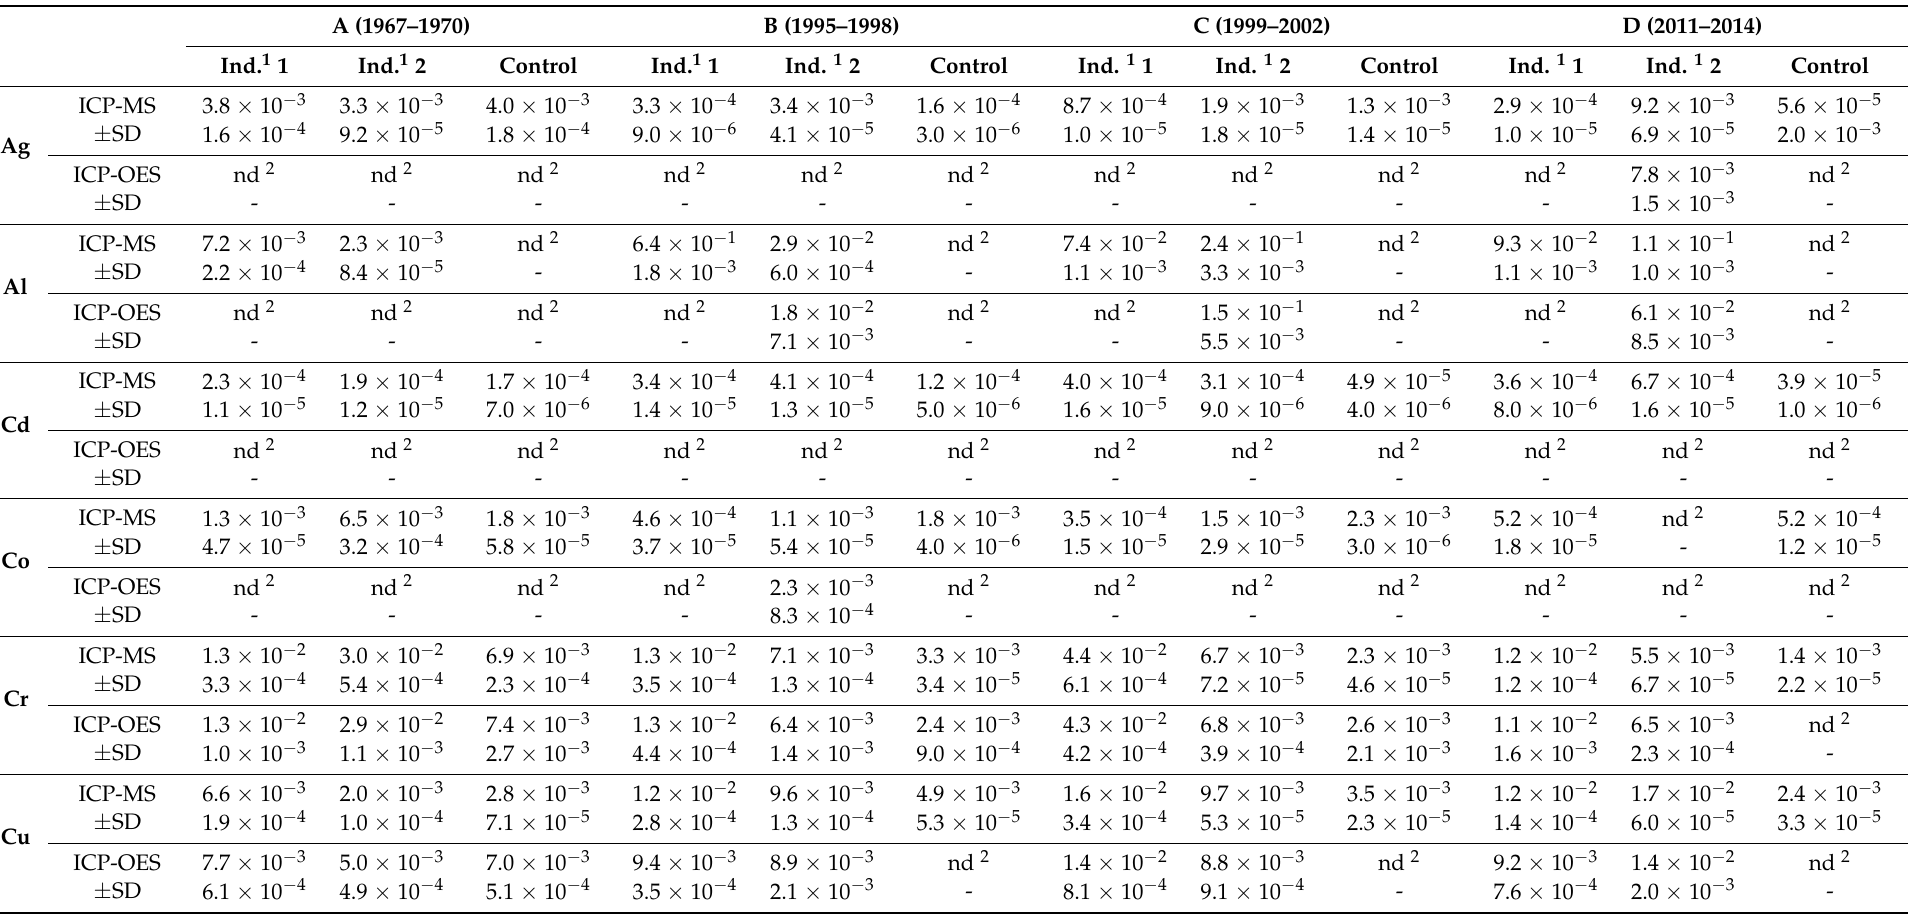
Table 3. TEs contents in mineralised solutions. Comparison of results obtained by inductively coupled plasma-mass spectrometry (ICP-MS) and inductively coupled